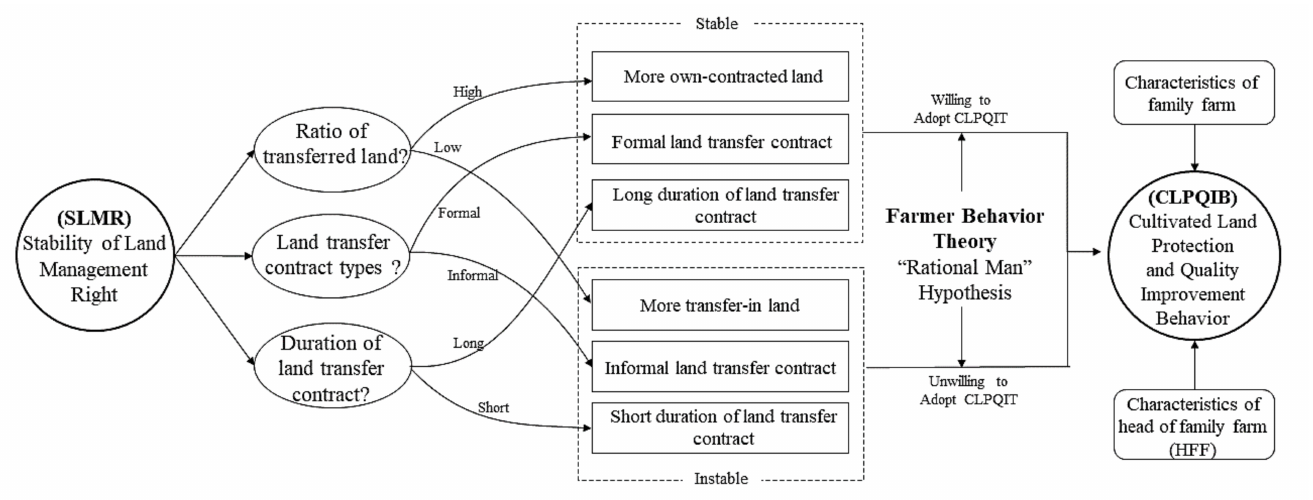
Figure 1. The logical framework of this